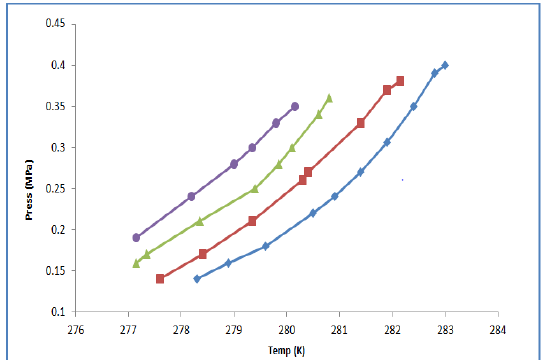
Fig. 9. R134ahydrate dissociation conditions for ternary system with KBr salt of this work: ■ inabsence salt, ■ 0.09 mol ∕ kg, ▲ 0.17mol.kg - 1 ● 0.26mol ∕ kg.